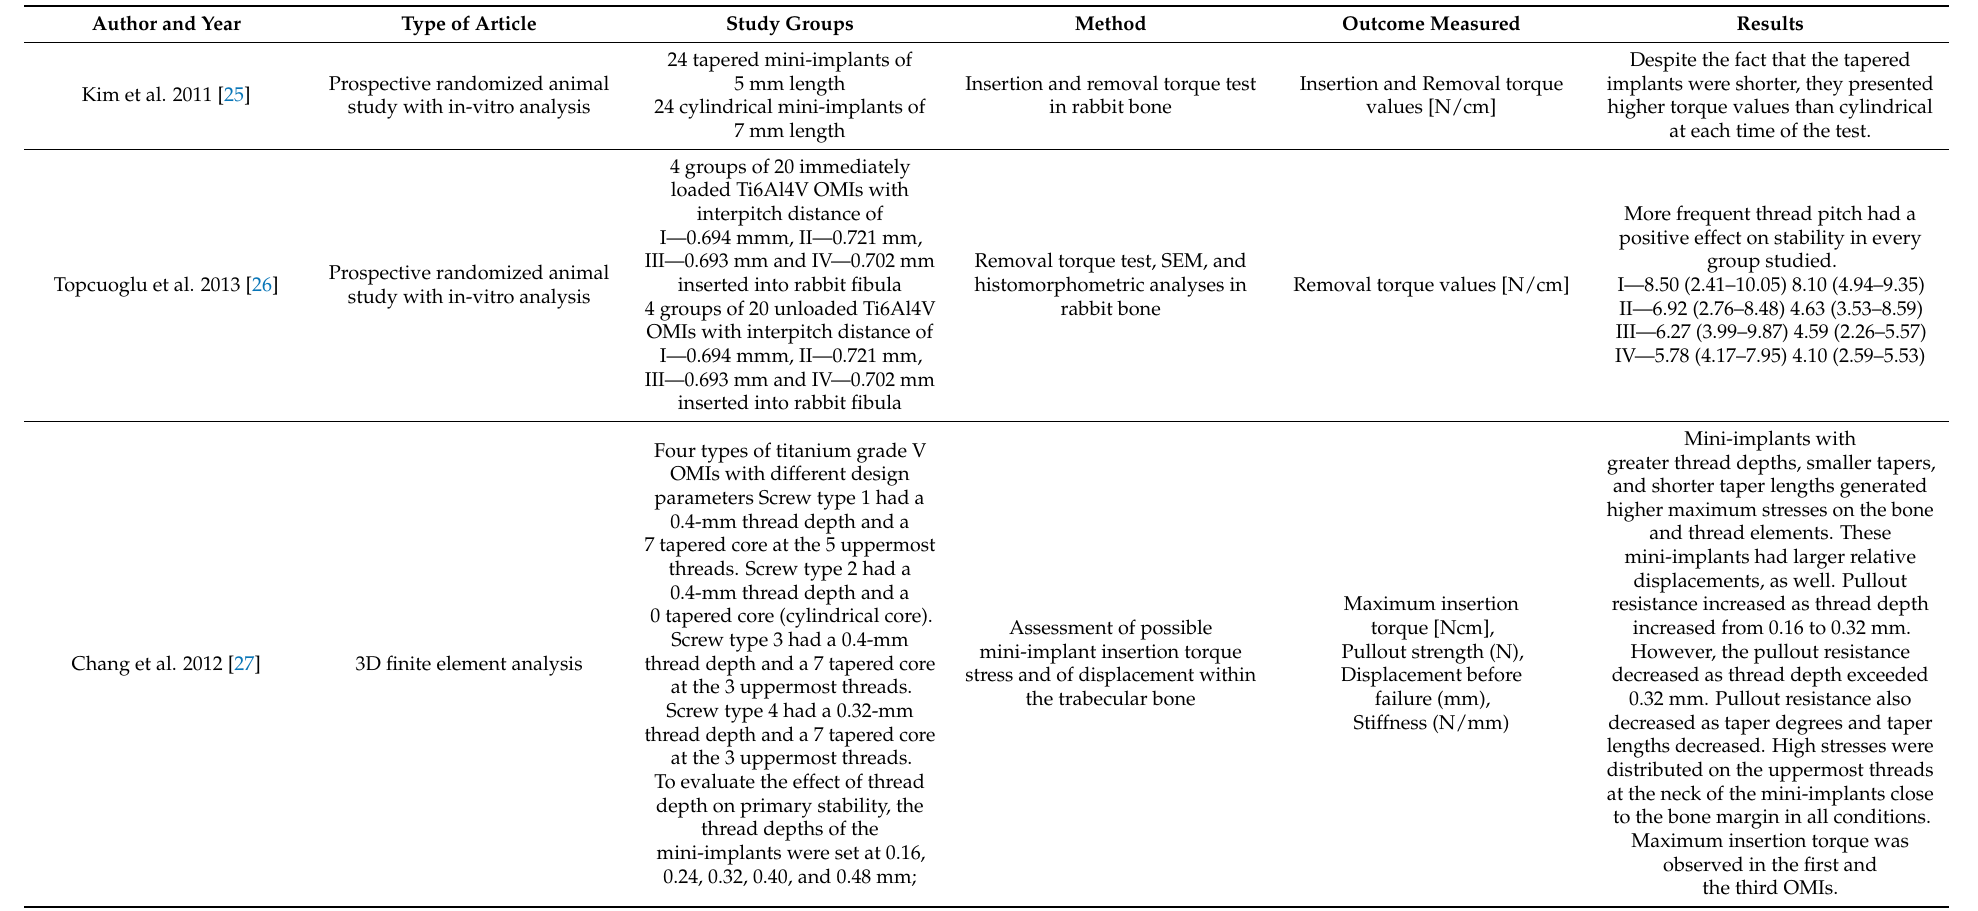
Table 1. Characteristics of included